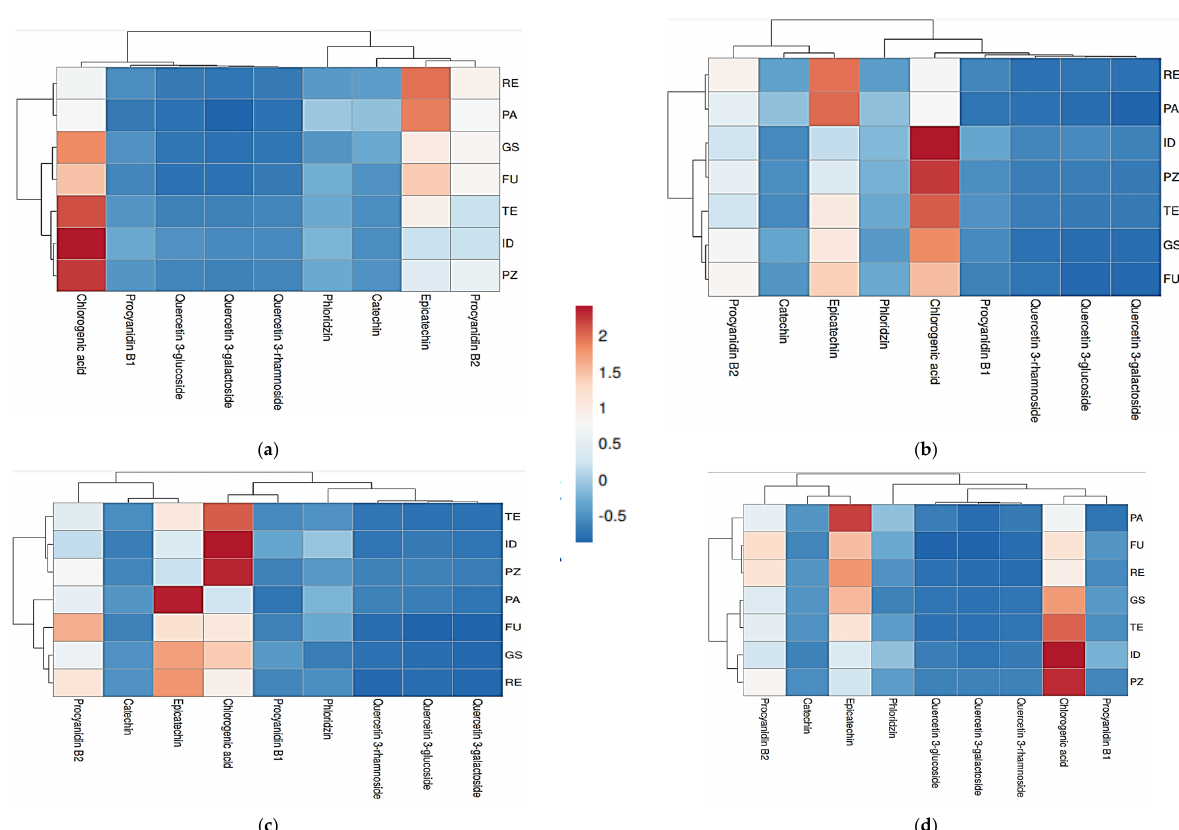
Figure 1. Heatmap of cloudy ( a ) and clear ( c ) juices without L-ascorbic acid and cloudy ( b ) and clear ( d ) juices with added L-ascorbic acid. Abbreviations: ID—‘Idared’, GS—‘Granny Smith’, PZ— ‘Prijedorska zelenika’, FU—‘Funtaˇca’, RE—‘Rebraˇca’, TE—‘Tetovka’, PA—‘Paradija’. Similarity of apple juices in polyphenolic compounds content is displayed by different colours which indicate lower (blue) and higher values